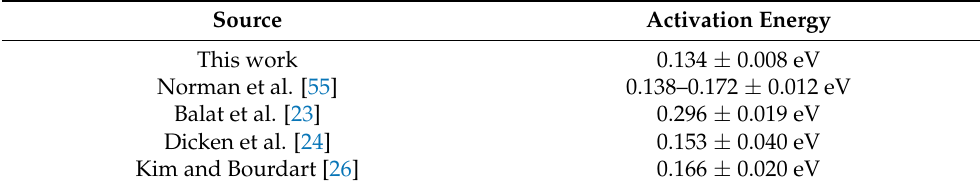
Figure 4. Comparisons of calculated surface catalytic recombination coefficient and the activation energy by Models 1–4. ( a ) The calculated surface catalysis recombination coefficient [23,24,26,55], and ( b ) the calculated activation energy [55]. Table 3. Comparison of the activation energy for surface catalysis reactions of Models